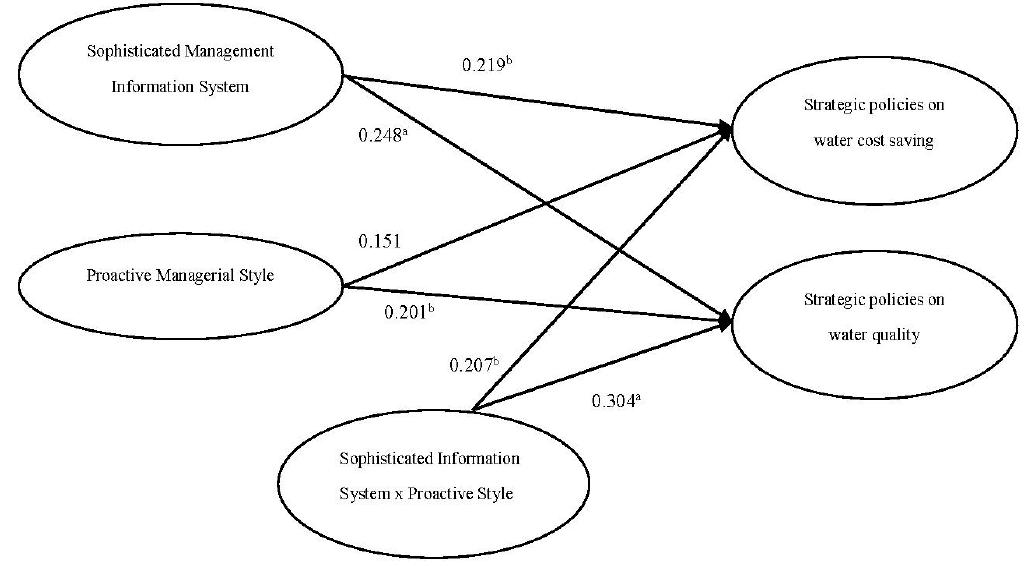
Figure 1. Results from the PLS research model. a Significant at the 0.01 level (two tailed); b Significant at the 0.05 level (two tailed). Table 3. Results from PLS analysis (path